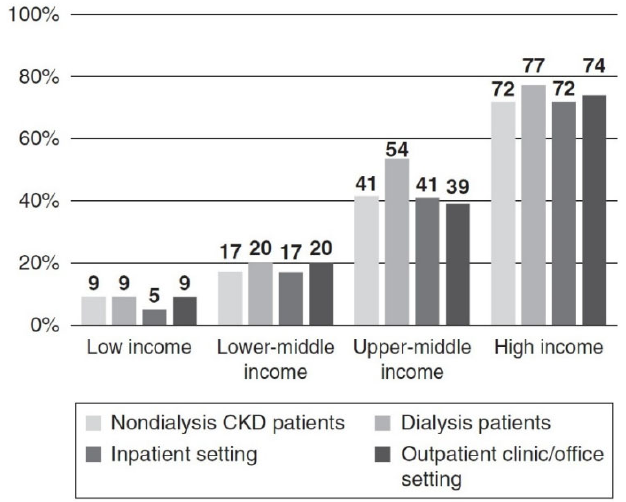
Figure 5. Global availability and capacity of kidney nutrition care. Dietitians/renal dietitians practice settings in outpatient and inpatient settings and nutrition care availability for nondialyzed CKD patients versus those undergoing maintenance dialysis for different World Bank income groups. Used with permission of the American Society of Nephrology, from Assessing Global Kidney Nutrition Care, Wang, A.Y. et.al., 17, 2022 of copyright